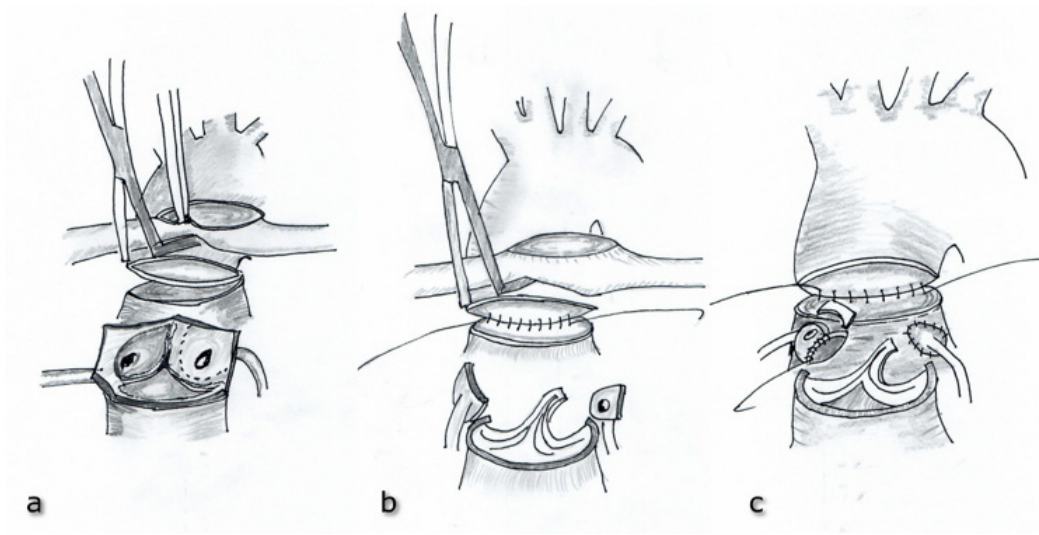
Fig. 1A – Coronary arteries are removed from their sinuses as a large ‘u shaped’ flap. Fig. 1B – The posterior half of anastomosis between the neo-aorta and ascending aorta is performed. Fig. 1C – Coronary reimplantation to the neo-aortic root.